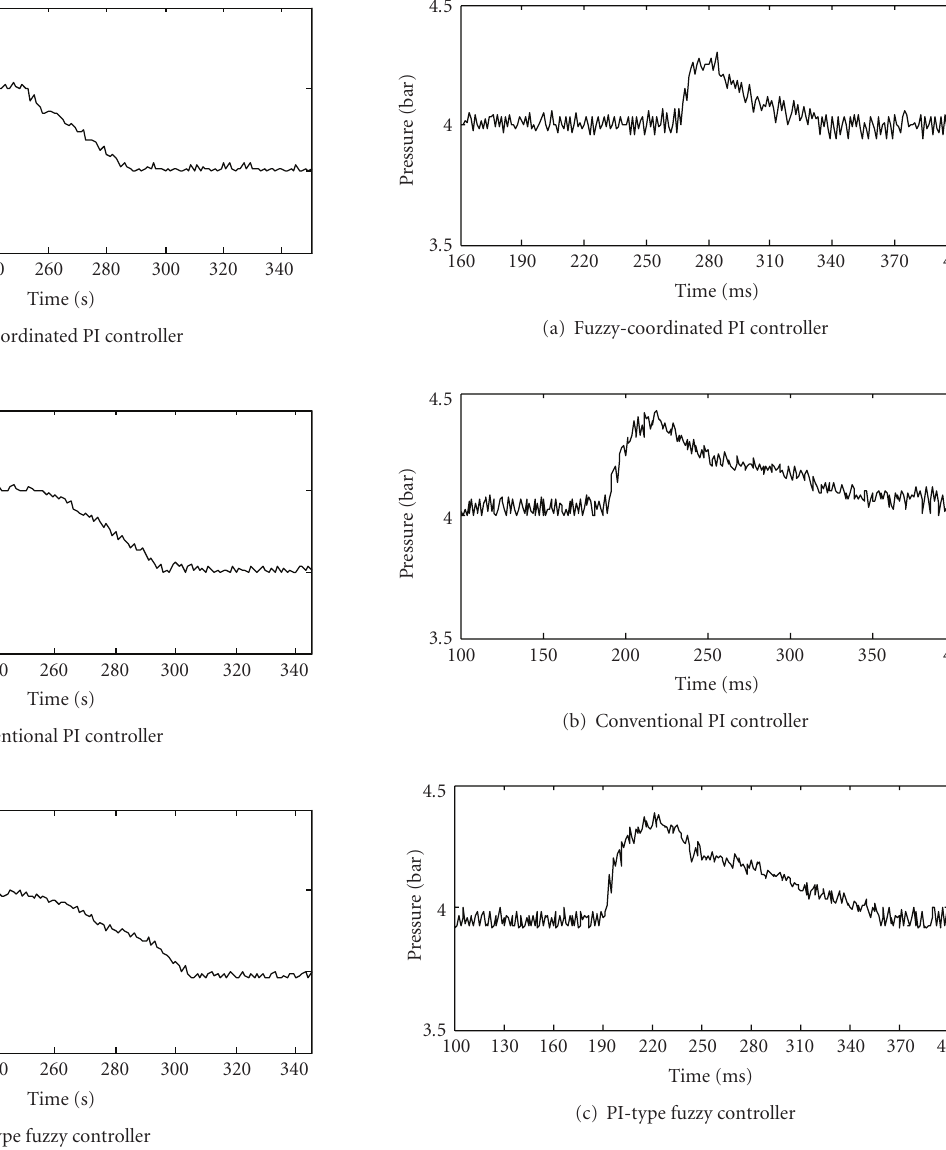
Figure 14: Experimental results, load disturbance response of controllers for increasing the process